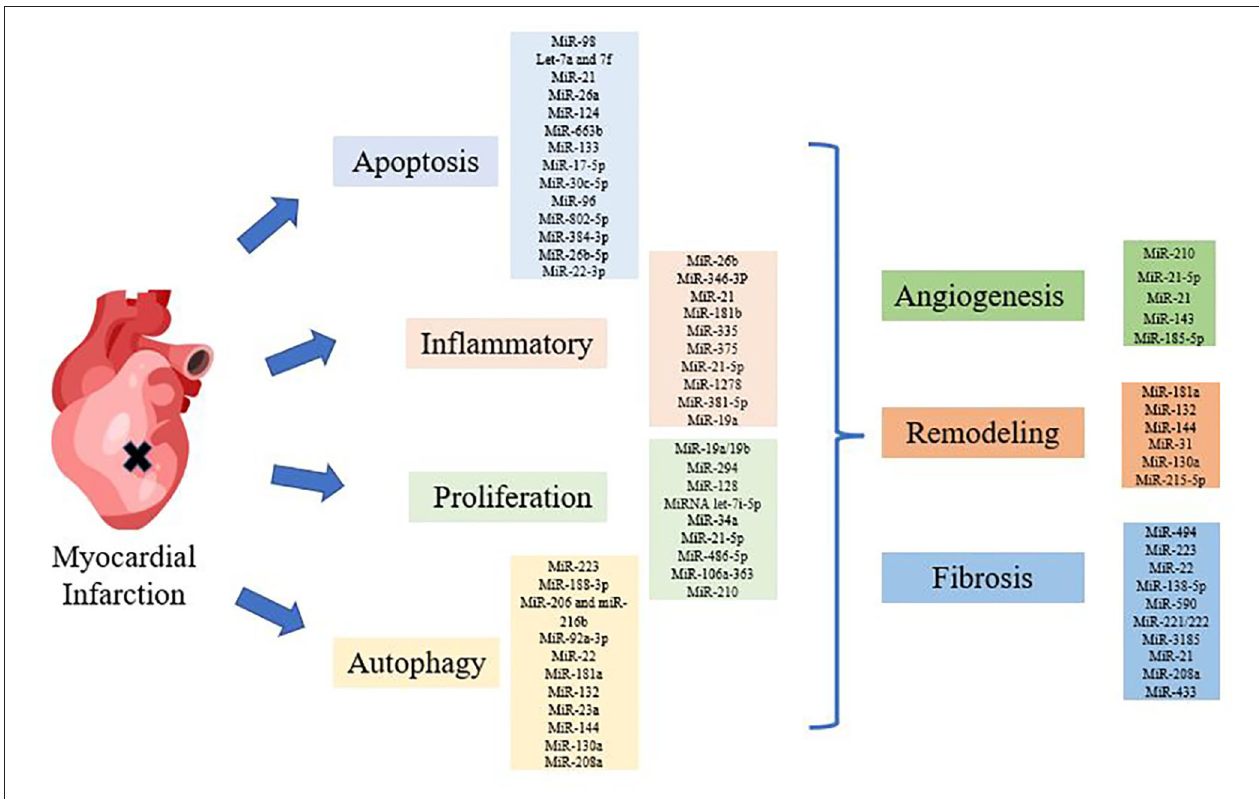
FIGURE 1 | Diagram of miRNAs regulating myocardial infarction (MI). Various miRNAs regulated MI through apoptosis, inflammation, autophagy, proliferation and structural changes, such as angiogenesis, remodeling, and fibrosis.